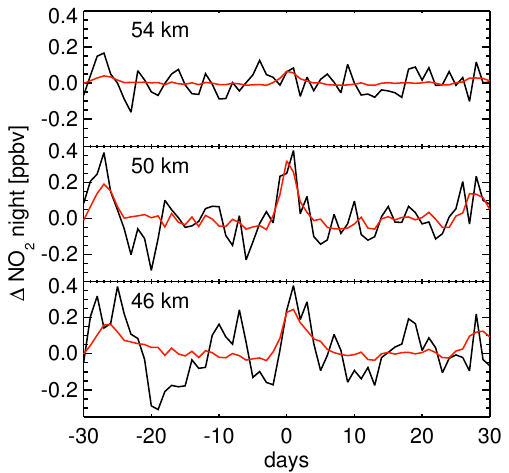
Fig. 9. Epoch type 1 SEA of ∆NO 2 at 65 ± 5 ◦ S geomagnetic latitude and 50km altitude. The blue error bars show the 1 σ range.